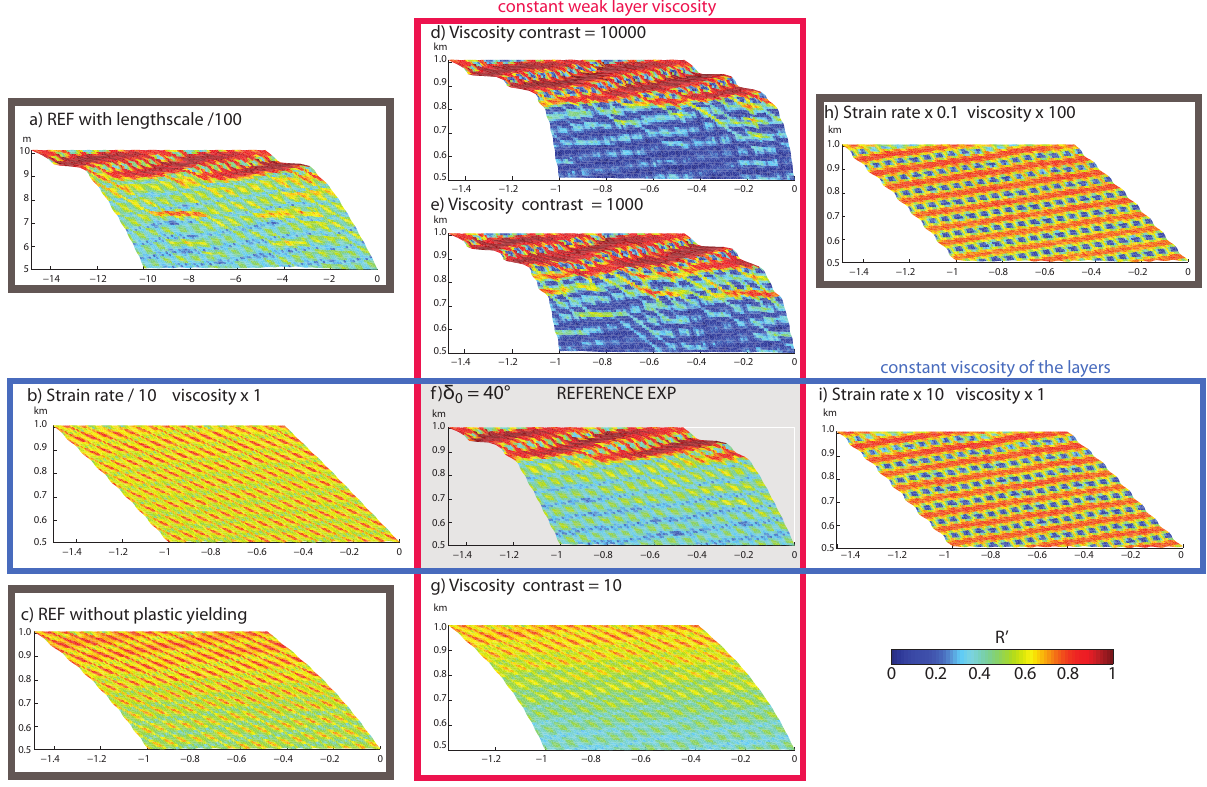
Fig. 9. Scaling of models. The reference model f is equivalent to δ 0 = 40 ◦ model. The blue box models represent the effect of varying the background strain rate. The red box models test the influence of the strength of strong layers. The grey frames denote three special runs. All changed parameters are listed in Table